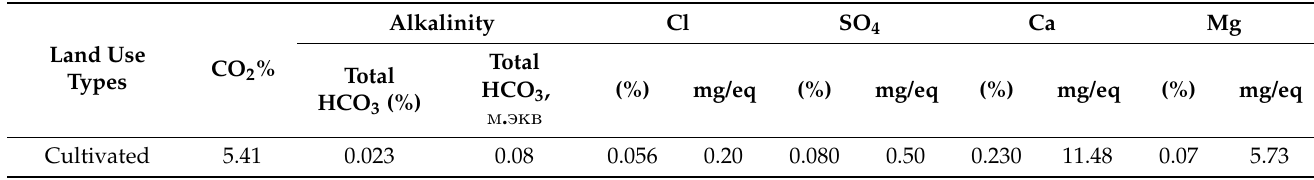
Table 9. The chemical properties of irrigated soil in the Kibray